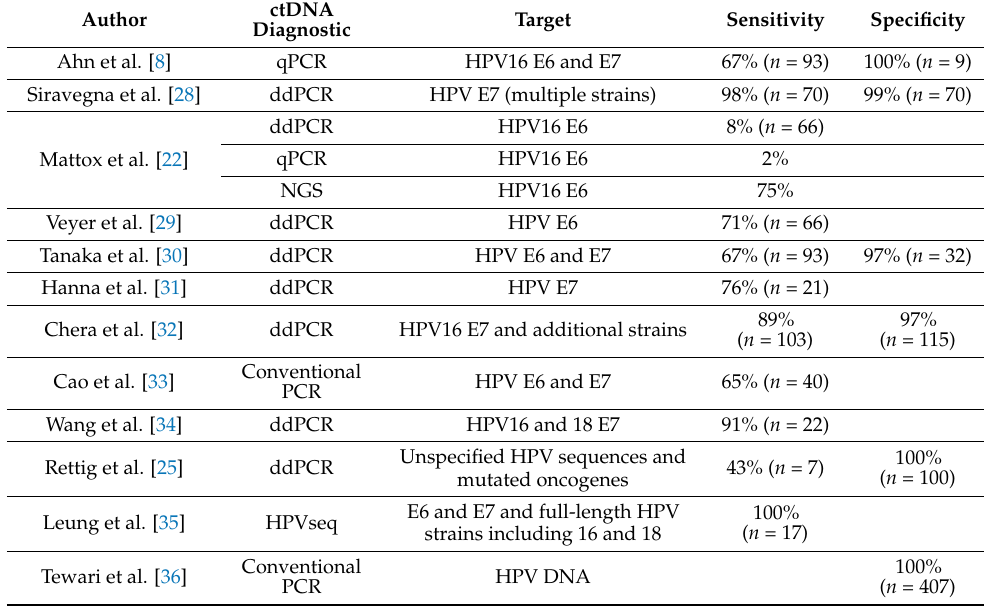
Table 1. Literature-reported sensitivity and specificity rates for ctHPV DNA